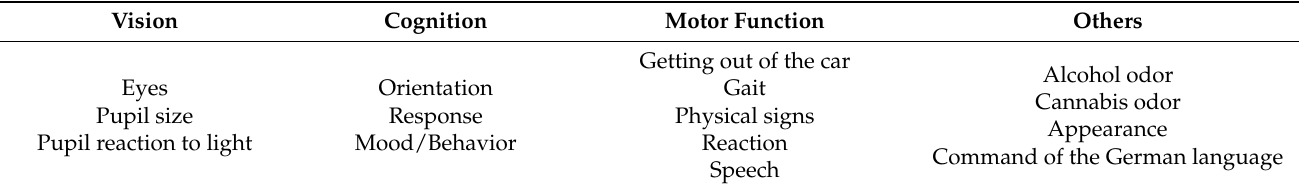
Table A1. Categorization of VERIFY checklist